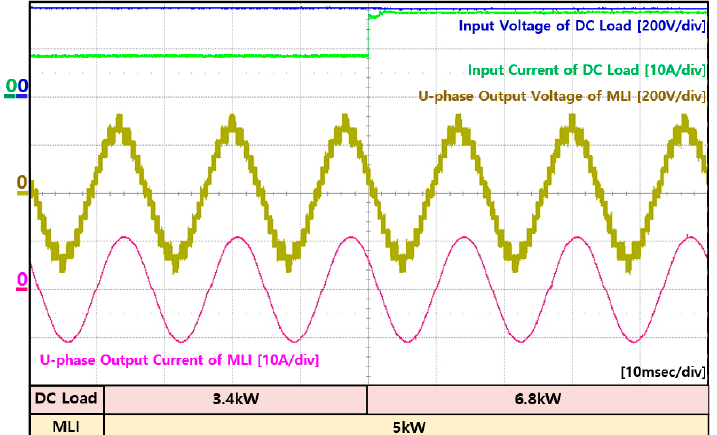
Figure 31. Experiment waveforms of interfacing converter at AC grid in mode 6.